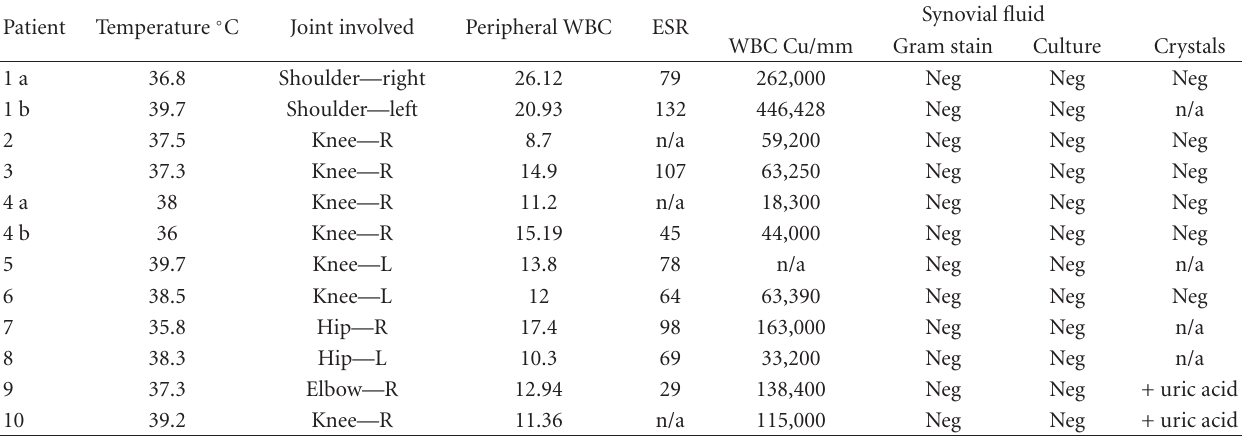
Table 2: Diagnostic